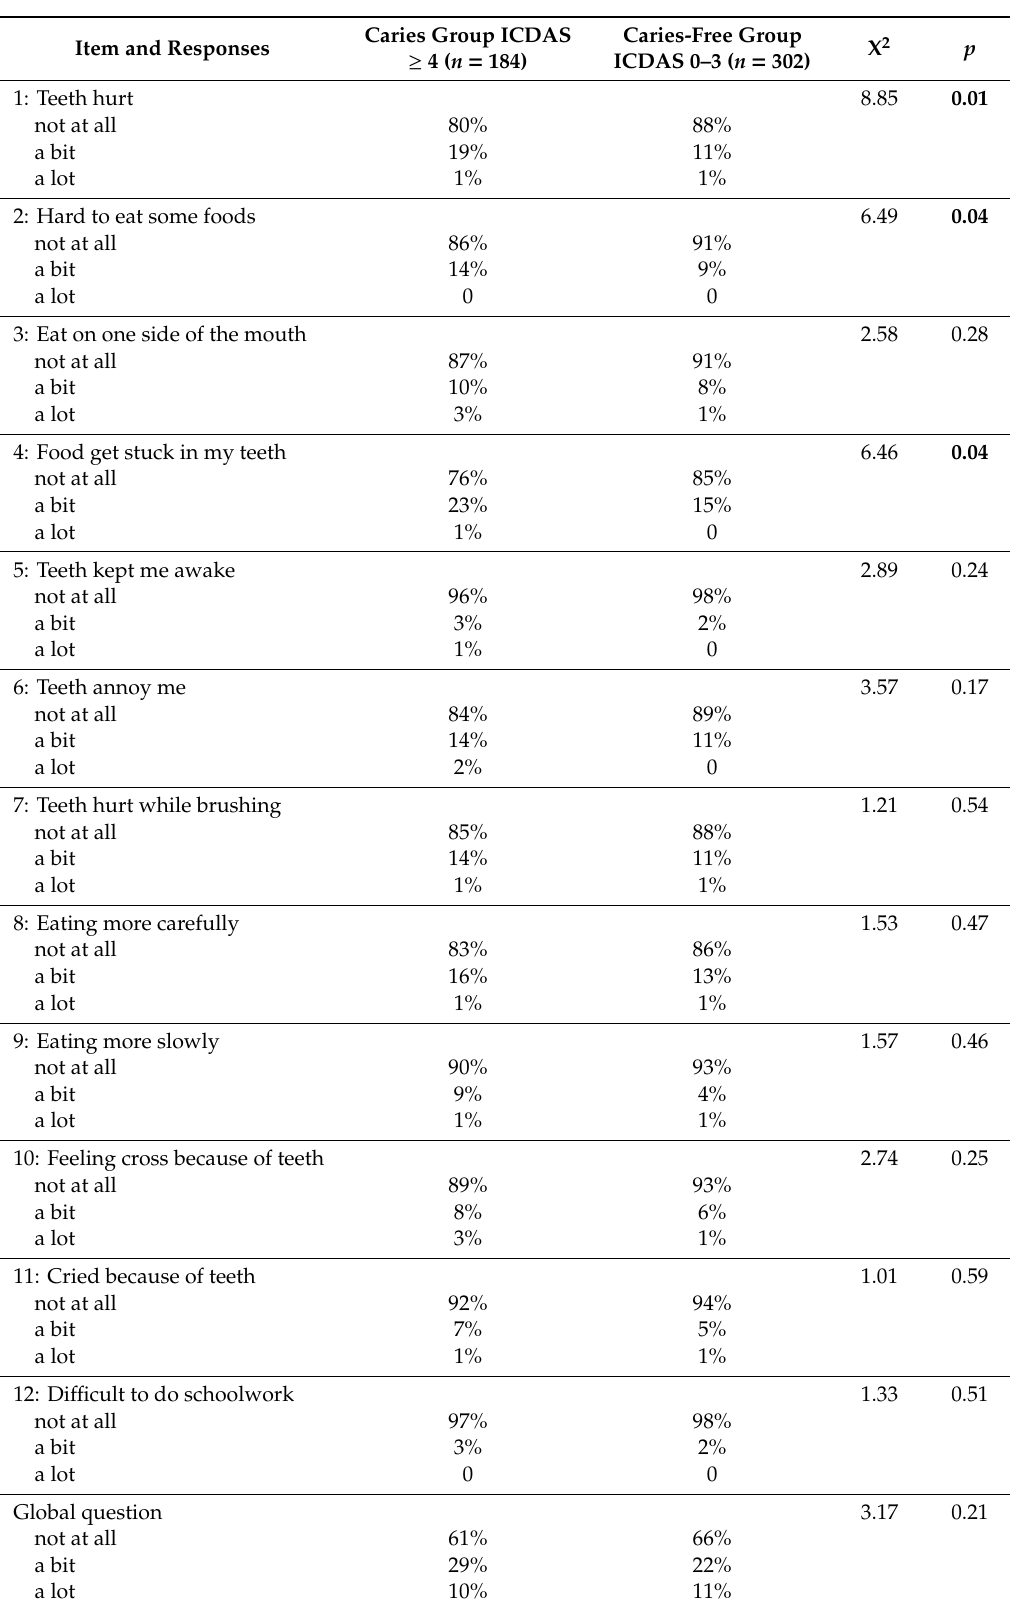
Table 3. Percentage of distribution of CARIES-QC in children with and without caries